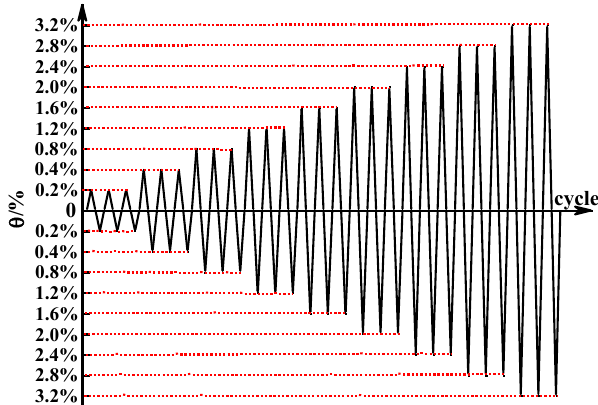
Figure 7. Test loading site.